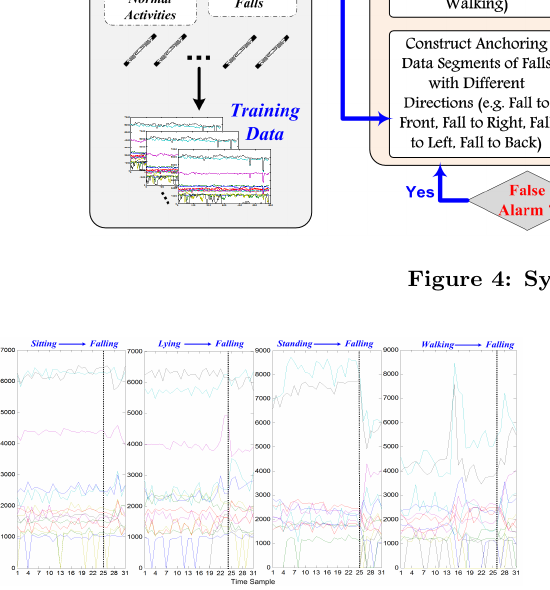
Figure 3: RSSIs variation patterns when a subject falls from different status